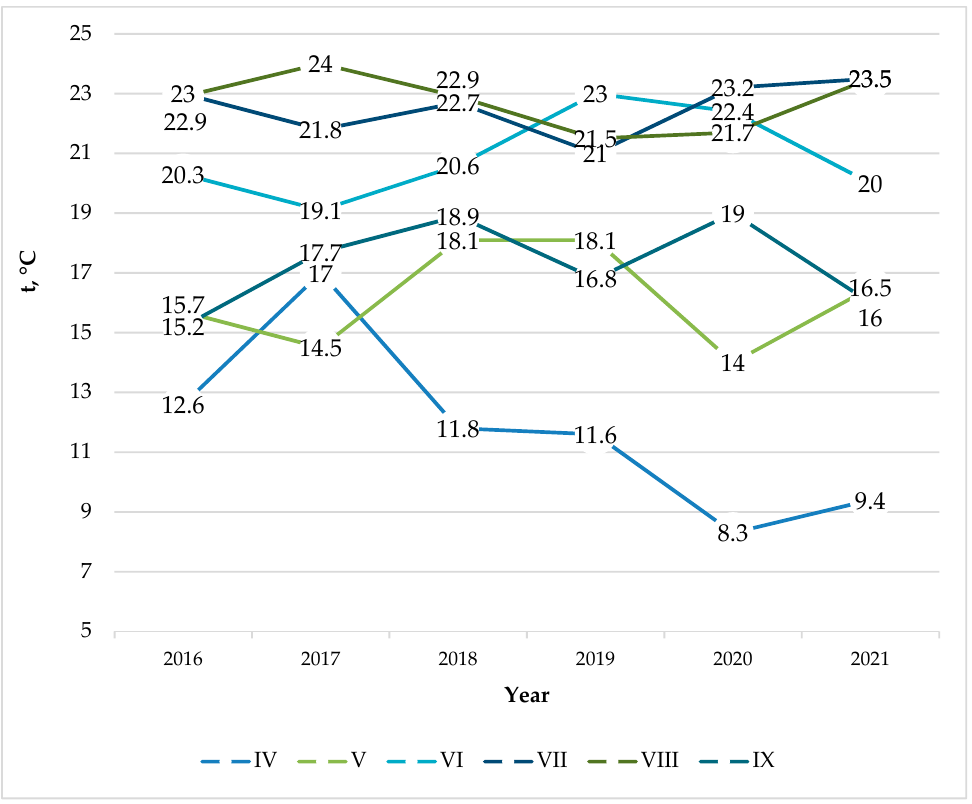
Figure 2. Average monthly temperature within the periods April–September in 2016–2021. Source: own elaboration.